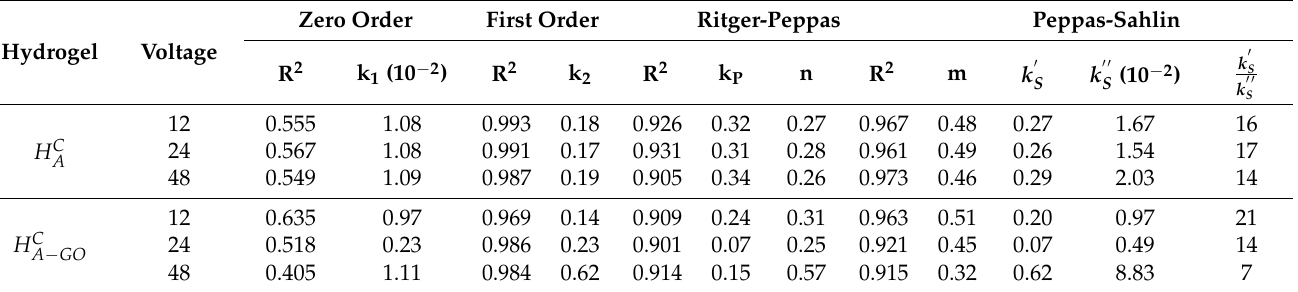
application of external voltages at 12, 24, and 48